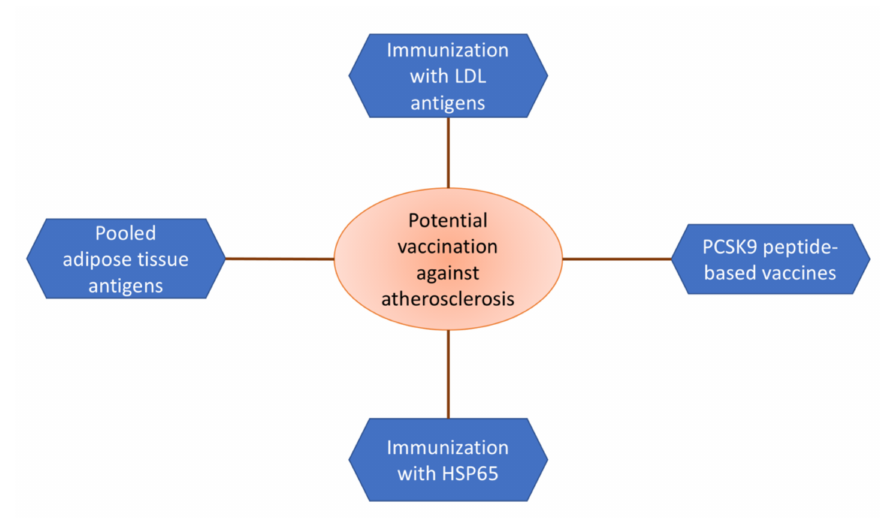
Figure 1. Variety of approaches to the development of an atherosclerosis